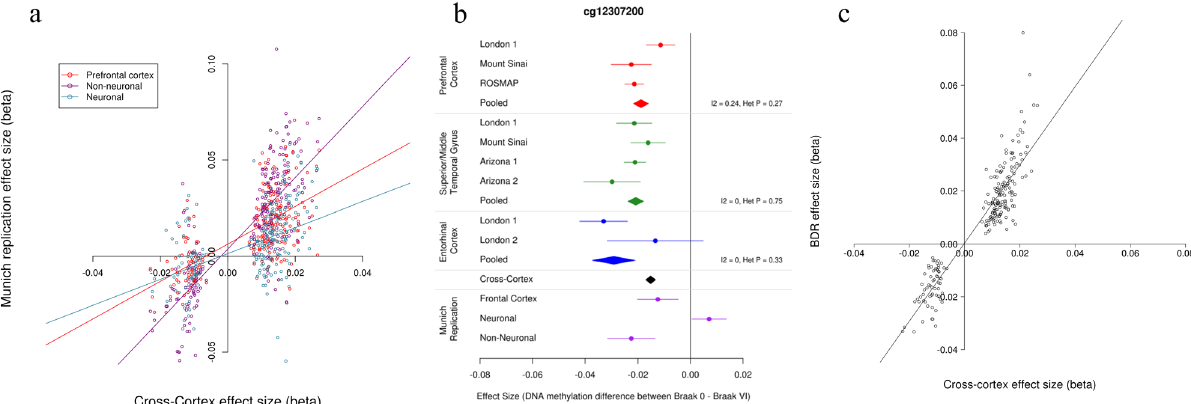
Fig. 3 Independent replication of the Bonferroni signi fi cant cross-cortex differentially methylated loci. a The methylation (beta) effect size (ES) of the 220 cross-cortex differentially methylated positions (DMPs) identi fi ed in the discovery ( N = 1408) cohorts ( X -axis) were signi fi cantly correlated with the ES in the Munich replication cohort in the prefrontal cortex (red; N = 45, r = 0.64, P = 5.24 × 10 − 27 ), sorted neuronal cells (light blue; N = 26, r = 0.45, P = 1.56 × 10 − 12 ) and non-neuronal cells (purple; r = 0.79, N = 26, P = 1.43 × 10 − 47 ) ( Y -axis). b A forest plot of the most signi fi cant cross-cortex DMP (cg12307200, chr3:188664632, P = 4.48× 10 − 16 ). The effect size is shown in the prefrontal cortex (red; N = 961), temporal gyrus (green; N = 608) and entorhinal cortex (blue; N = 189) for the different discovery cohorts. The X -axis shows the beta ES, with dots representing ES and arms indicating standard error (SE). ES from the intra-tissue meta-analysis using all available individual cohorts are represented by polygons in the corresponding tissue colour. The black polygon represents the cross-cortex data. Shown in purple on the plot is the ES in the Munich replication cohort in the prefrontal cortex and sorted neuronal cells and non-neuronal cells, with the direction of effect suggesting the hypomethylation seen in the discovery cohorts is driven by changes in non-neuronal cells. c In the BDR replication cohort ( N = 590) DNA methylation data were available in the prefrontal cortex for 208 of the 220 Bonferroni signi fi cant cross-cortex DMPs. The ES of these 208 cross-cortex DMPs in the discovery cohorts ( X -axis) were signi fi cantly correlated with the ES in